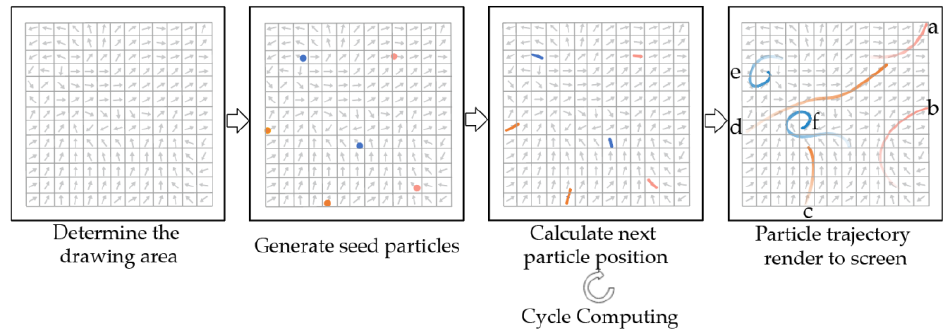
Figure 6. Schematic diagram of particle trace generation.